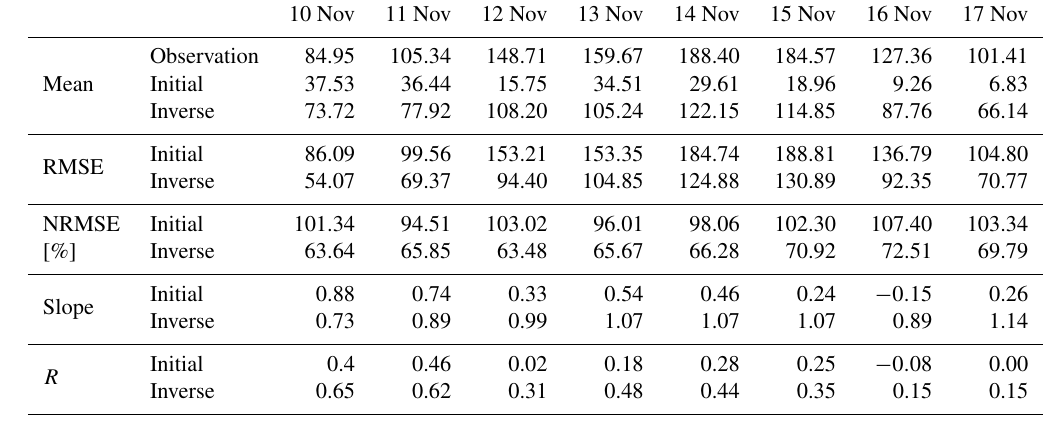
Table 1. Performance evaluation. Statistics of modeled smoke mass loading ( × 10 − 6 kgm − 2 ) using initial and top-down estimated fire emissions.